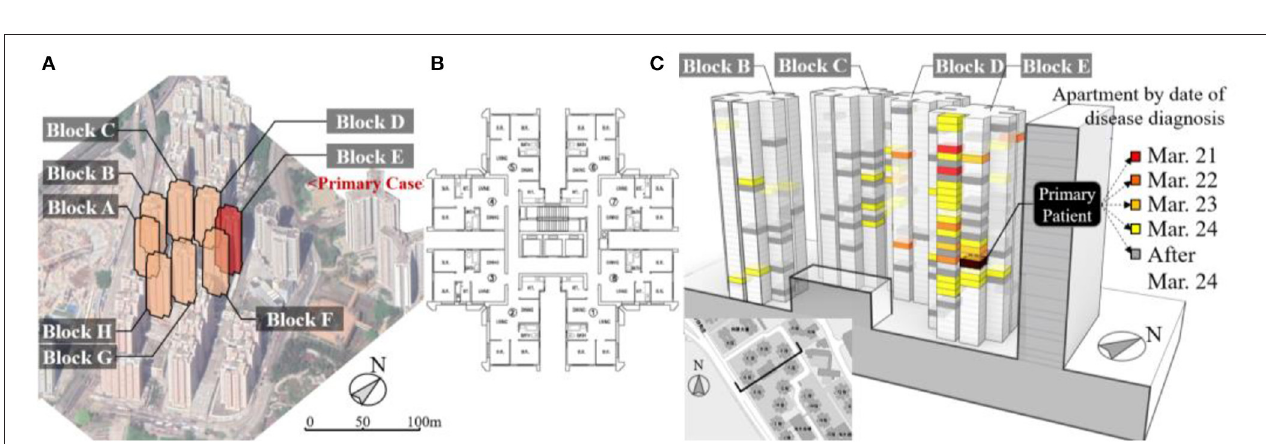
FIGURE 2 | (A) The mock-up high-density city site and the smoke tracer experiment layout; (B) a screenshot of a video taken during the smoke tracer experiment, with the metal combustion chamber with smoke cake inside; (C) deployment of particle mass spectrometer; and (D) deployment of thermal couples on the concrete bin façade, roof, and the ground.